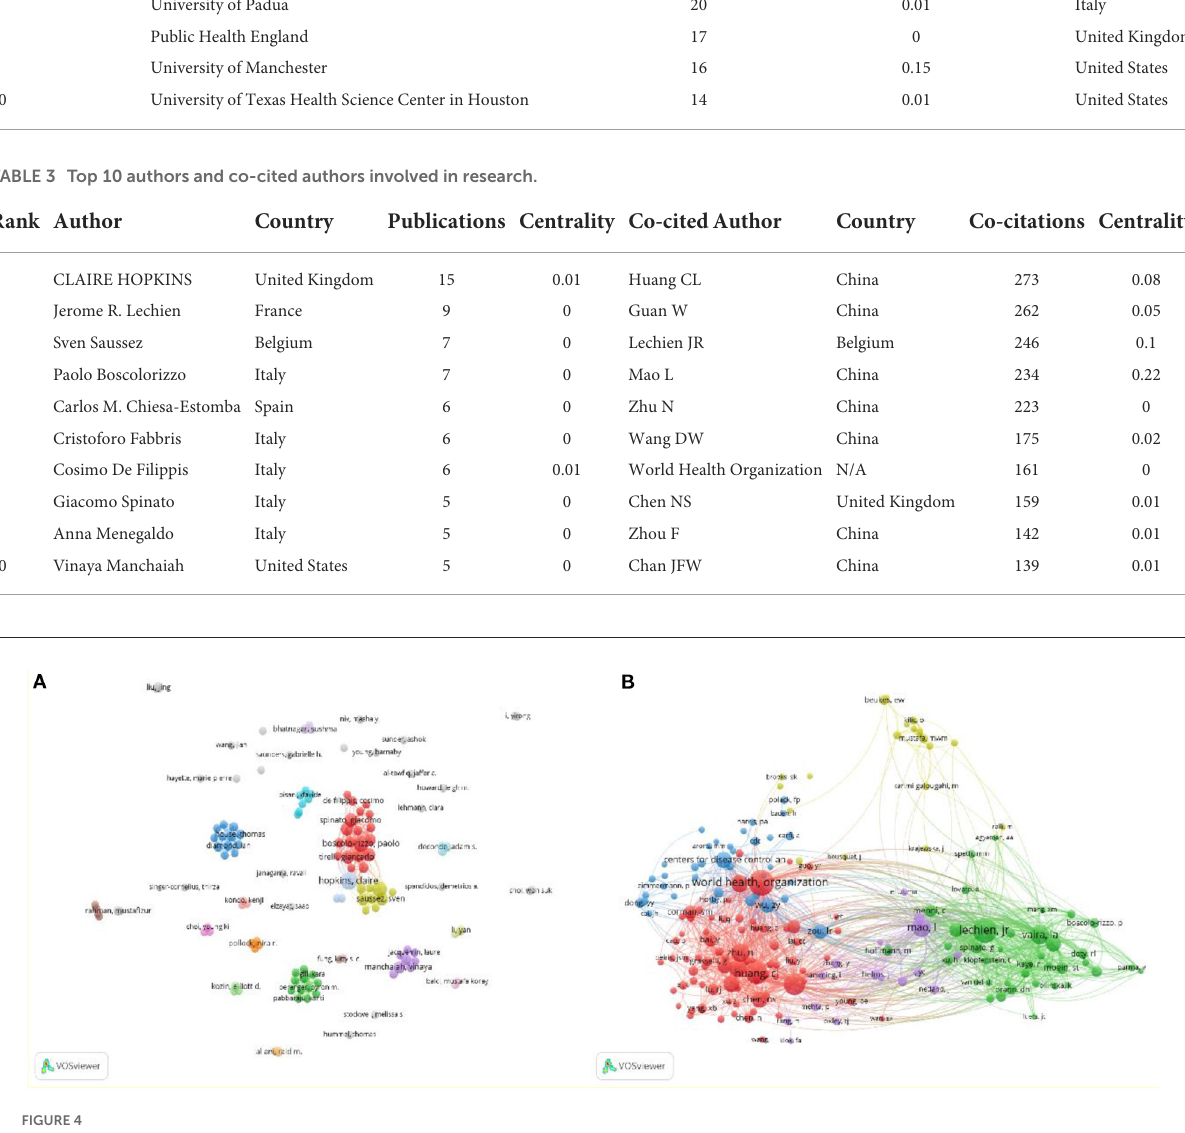
ranked the top three. Among them, Huang CL has the highest centrality (0.08). The supplementary figure showed the author cooperation network (Figure 4A) and co-cited